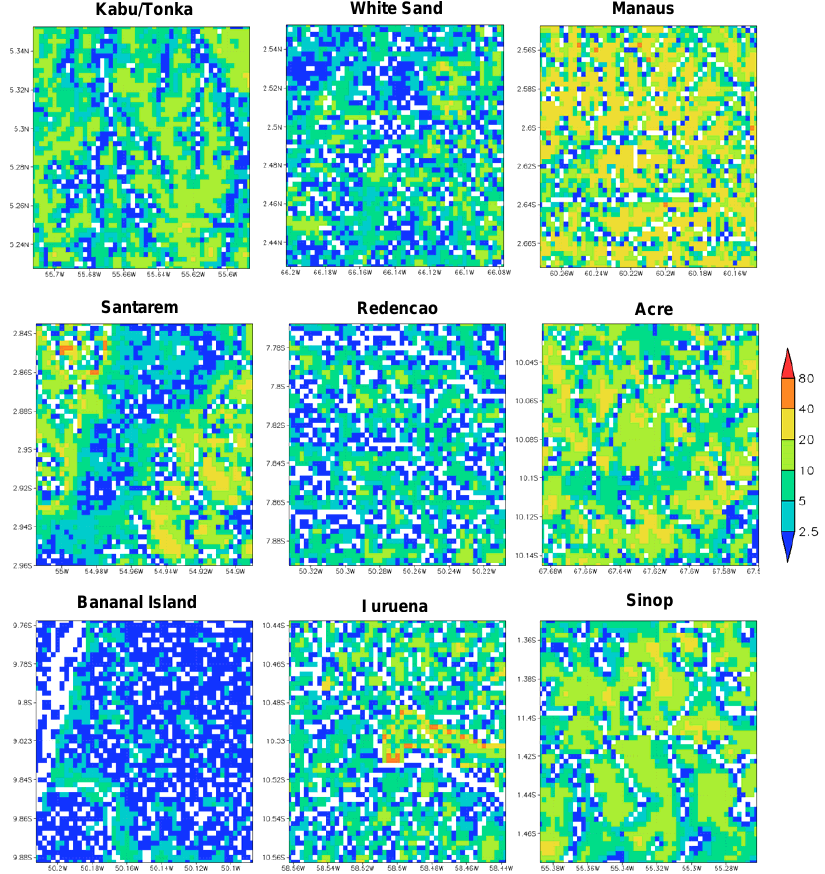
Fig. 10. Simulated WTD (m) surrounding the nine sites (Fig. 9) with WTD observations (white cell = WTD at land surface).